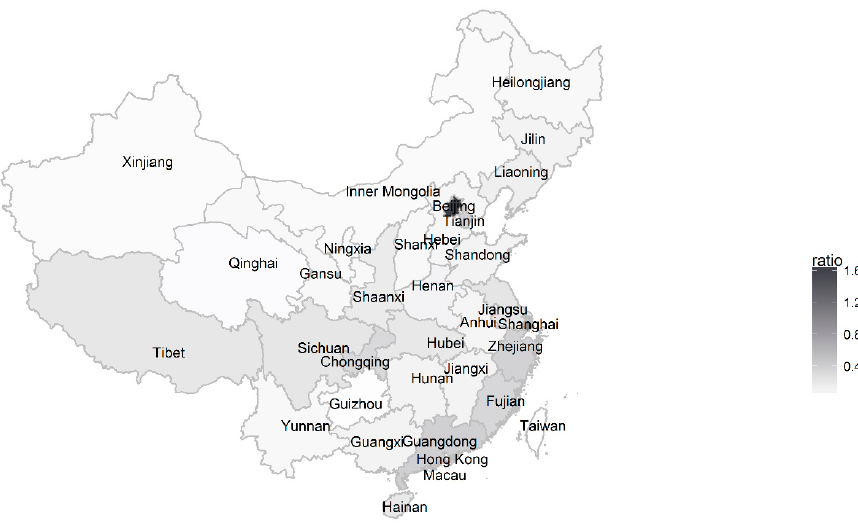
Figure 2. Geographic distribution of users with anxiety.